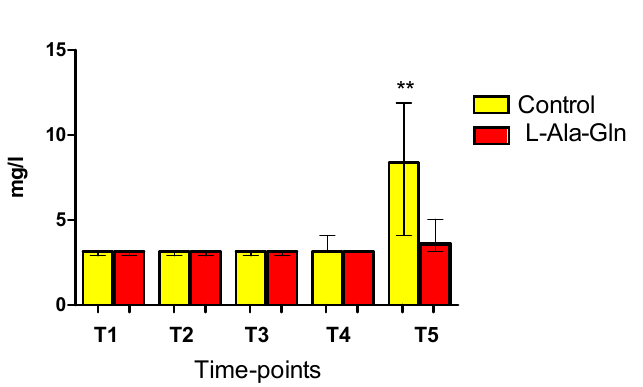
FIGURE 5 - CRP concentrations (mg/l) in the plasma of saline (control) and L-Ala-Gln-treated patients. Bars represent median with interquartile range of control (yellow bars) and L-Ala-Gln (red bars) groups during different time-points. Groups studied are not significantly different by ANOVA test (Friedman). CPR levels increased significantly in control patients, comparing T-5 with basal values (T-1). ** P< 0.05 compared with T1 (control group).